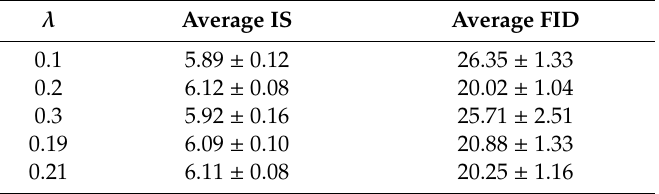
Table A10. We compared the IS and FID of di ff erent λ synthetic images when image edge smoothing was performed. The data we compared was λ = 0.1, λ = 0.2, λ = 0.3, λ = 0.19, and λ = 0.21. The image pyramid algorithms we used were bilinear interpolation. We gathered statistics for 10 training exercises, and the di ff erence was statistically significant ( p < 0.05).